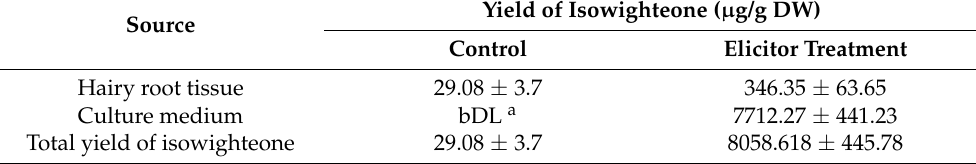
Table 2. Yield of isowighteone in the hairy root culture of pigeon pea (line G4). Twelve-day-old cultures were co-treated with methyl jasmonate, methyl- β -cyclodextrin, hydrogen peroxide, and magnesium chloride.